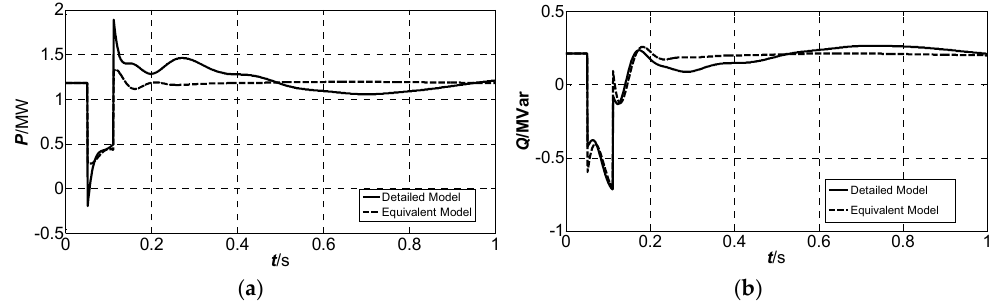
Figure 5. ( a ) The active power dynamics of the detailed model and the equivalent model of the Microgrid; ( b ) The reactive power dynamics of the detailed model and the equivalent model of the Microgrid. Table 1. A group of feasible parameters for the equivalent model.